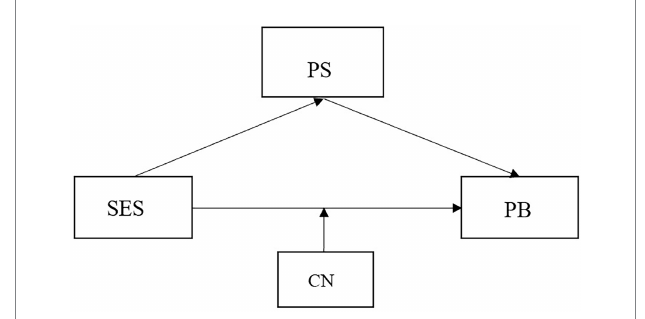
FIGURE 1 Theoretical model. SES, socioeconomic status; PS, parenting style; PB, problem behaviors; CN, child